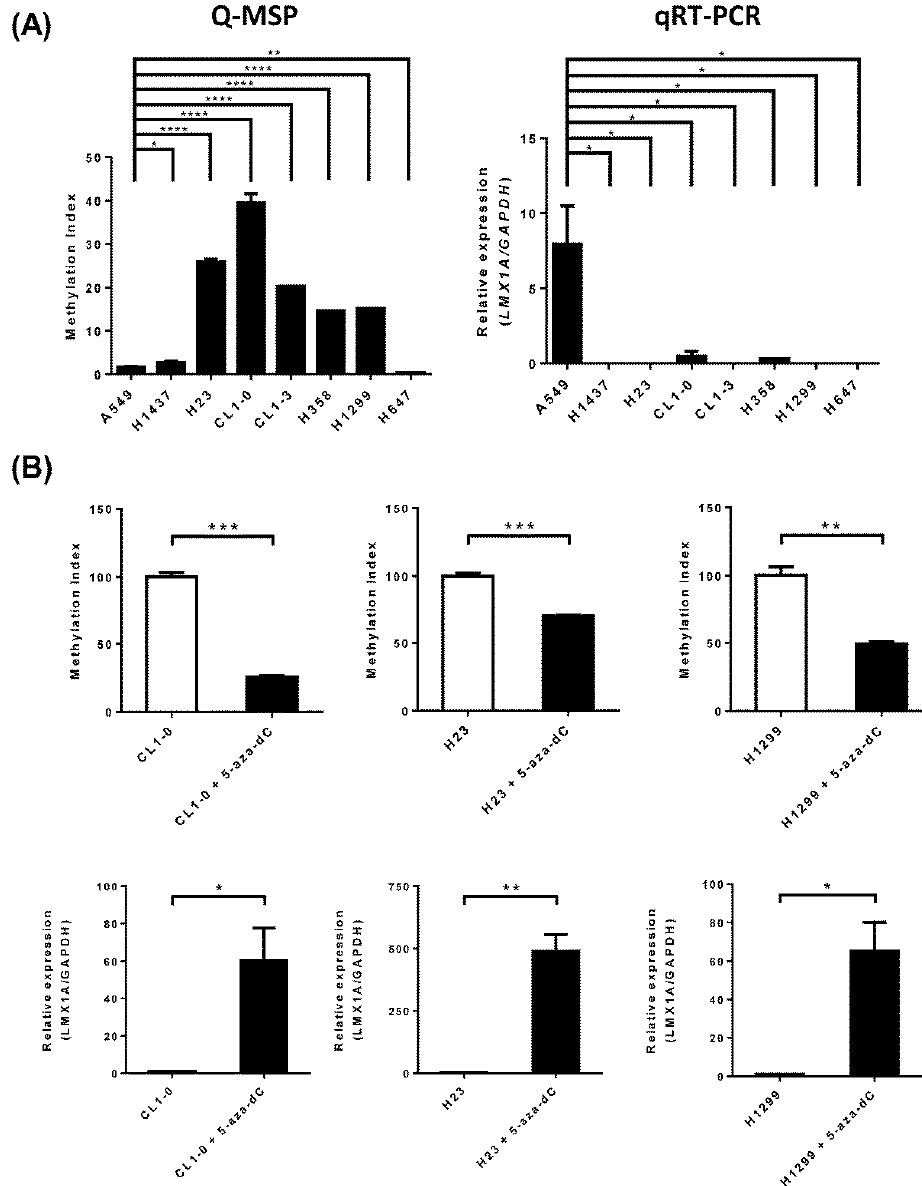
Figure 3. Correlation between methylation status and gene expression level of LMX1A in NSCLC cell lines. ( A ) Quantitative DNA methylation levels of LMX1A in eight NSCLC cell lines were analyzed by Q-MSP. Gene expression levels of LMX1A and the internal reference GAPDH were analyzed by quantitative RT-PCR. ( B ) Quantitative DNA methylation levels of LMX1A in CL1-0, H23, and H1299 cells treated with 5 µ M 5-aza-2 (cid:48) -deoxycytidine (DAC) or left untreated were determined by Q-MSP. The results are represented as di ff erences in the methylation index (MI). Gene expression levels of LMX1A and the internal reference GAPDH in CL1-0, H23, and H1299 cells treated with 5 µ M DAC or left untreated were analyzed by quantitative RT-PCR. * p < 0.05, ** p < 0.01, *** p < 0.001, and **** p < 0.0001 (Student’s t